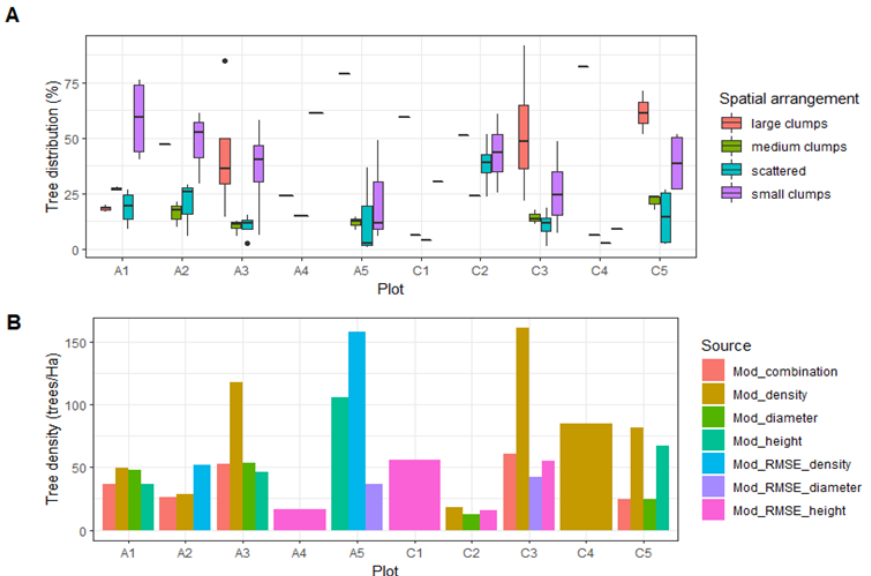
Figure 6. Tree density and spatial arrangements in livestock landscapes. ( A ) Tree distribution for spatial arrangement; ( B ) tree density according to parameter-combination criteria.